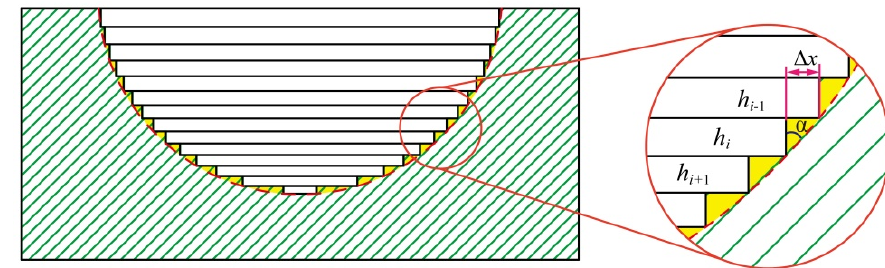
Figure 2. Schematic diagram of changing thickness proportionally.